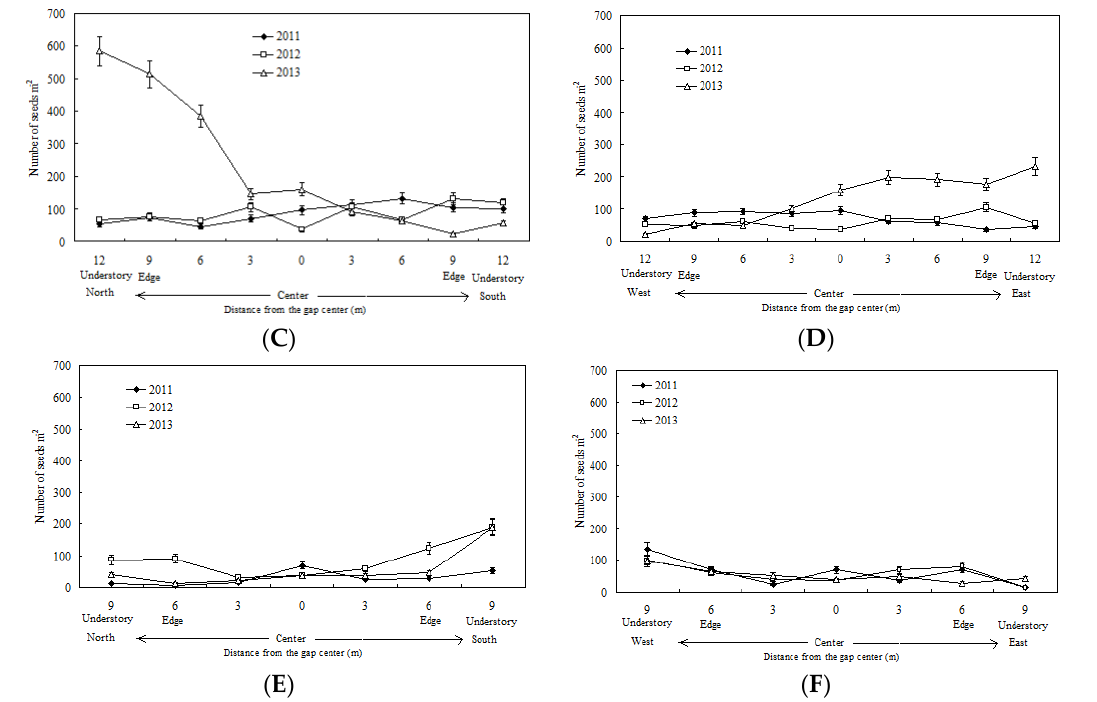
Figure 2. Spatiotemporal distribution patterns of the seed rain density. ( A ) north-south transect in large gaps; ( B ) west-east transect in large gaps; ( C ) north-south transect in medium gaps; ( D ) west- east transect in medium gaps; ( E ) north-south transect in small gaps; ( F ) west-east transect in small gaps.